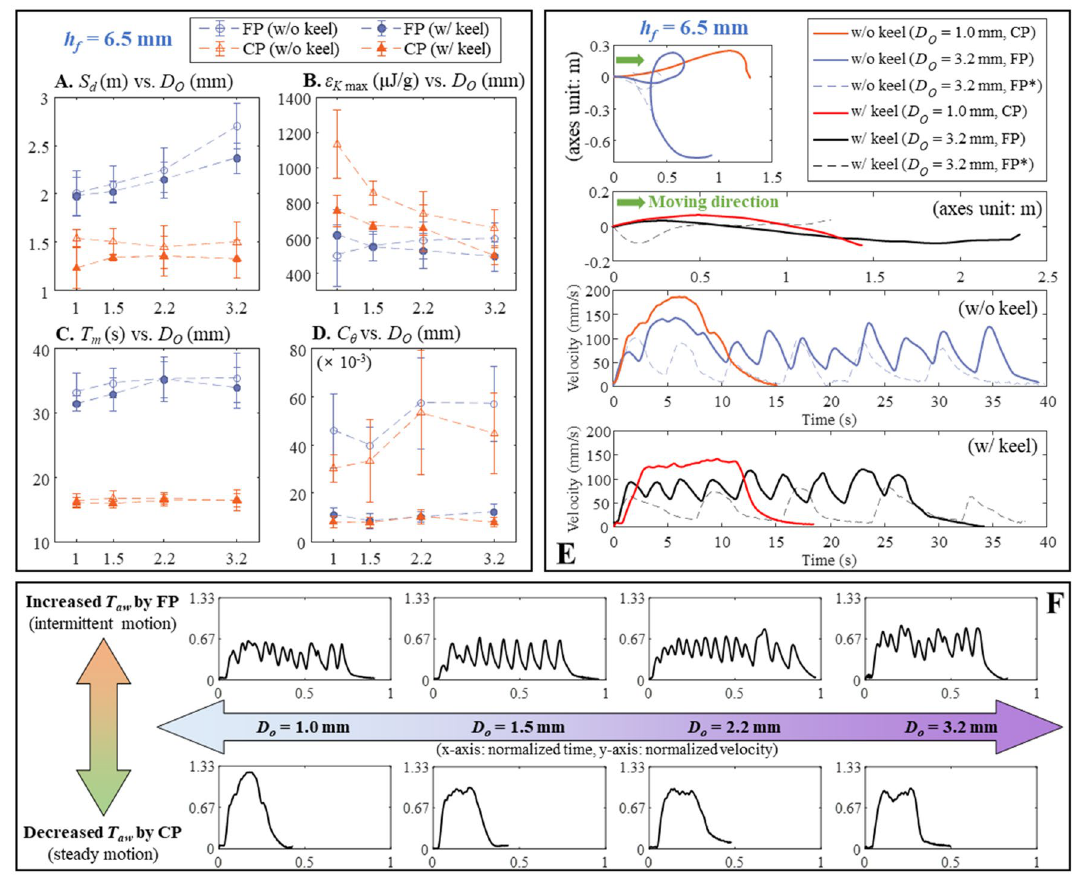
Figure 6. Robot locomotory characteristic at h f = 6.5 mm. ( A ) Traveled distance ( S d ) versus D O . ( B ) Energy density of fuel ε K , max versus D O . ( C ) Duration of motion T m versus D O . ( D ) Moving trajectory characteristic C θ versus D O ( n = 5 for A – D ). ( E ) Variation of velocity and corresponding moving trajectories of some selected cases. ( F ) The variation of normalized velocity of the robot upon T aw change; note that Fig. 4F and ( F ) were normalized in the same scale. Note that all the error bars denote standard